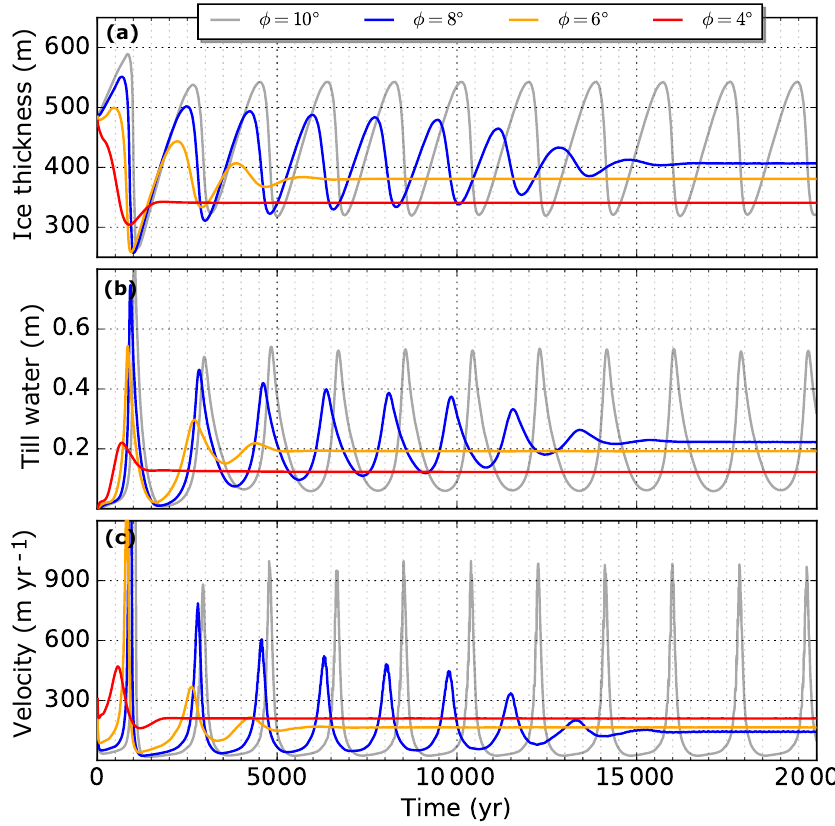
Figure 6. Time series of (a) ice thickness H , (b) till water thickness W till and (c) ice velocity (all averaged over area of grounded ice) for different values of the till friction angle ( φ ≤ 10 ◦ ). Between φ = 10 (default case) and φ = 8 there is a transition from maintained cyclic surging to damped